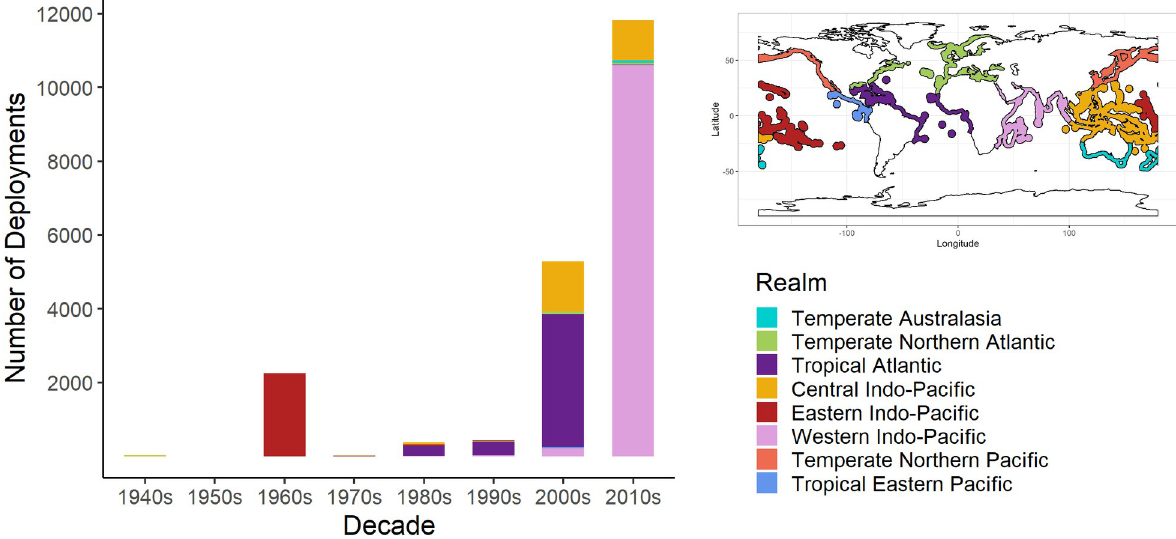
Fig 2. Abundance of tropical and subtropical (up to 35˚ latitude) deployments of ARs in each marine realm by decade of deployment from 1940s to 2010s. Inset shows marine realms defined by [48].